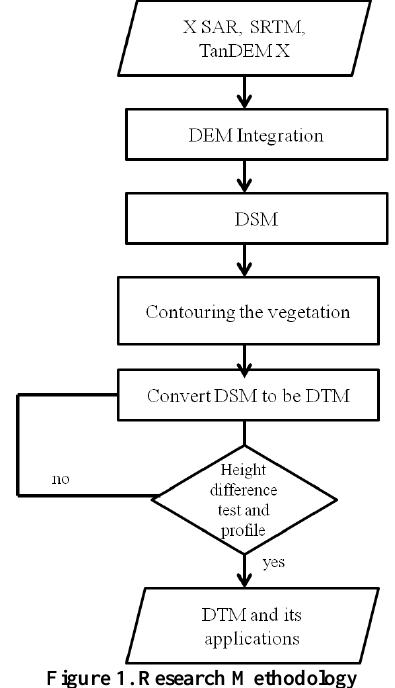
Figure 1. Research